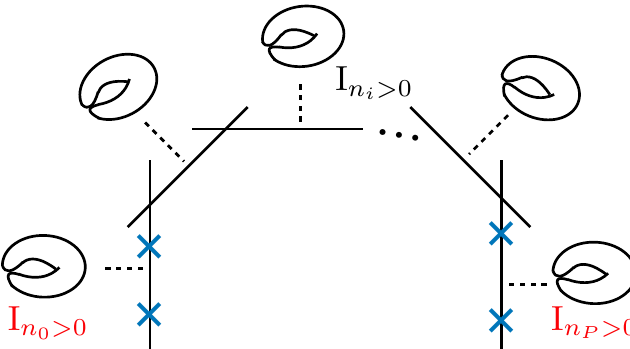
Figure 3 . Weierstrass model underlying elliptic Kulikov Type III.b degenerations. The blue crosses denote D -type singularities in codimension